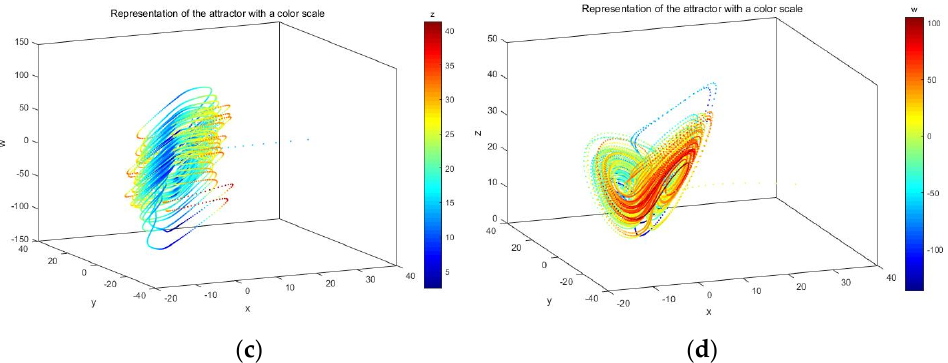
Figure 3. Phase diagrams of the Chen hyperchaotic attractor: ( a ) Phase diagram of the y − z − w plane; ( b ) Phase diagram of the x − z − w plane; ( c ) Phase diagram of the x − y − w plane; ( d ) Phase diagram of the x − y − z plane.